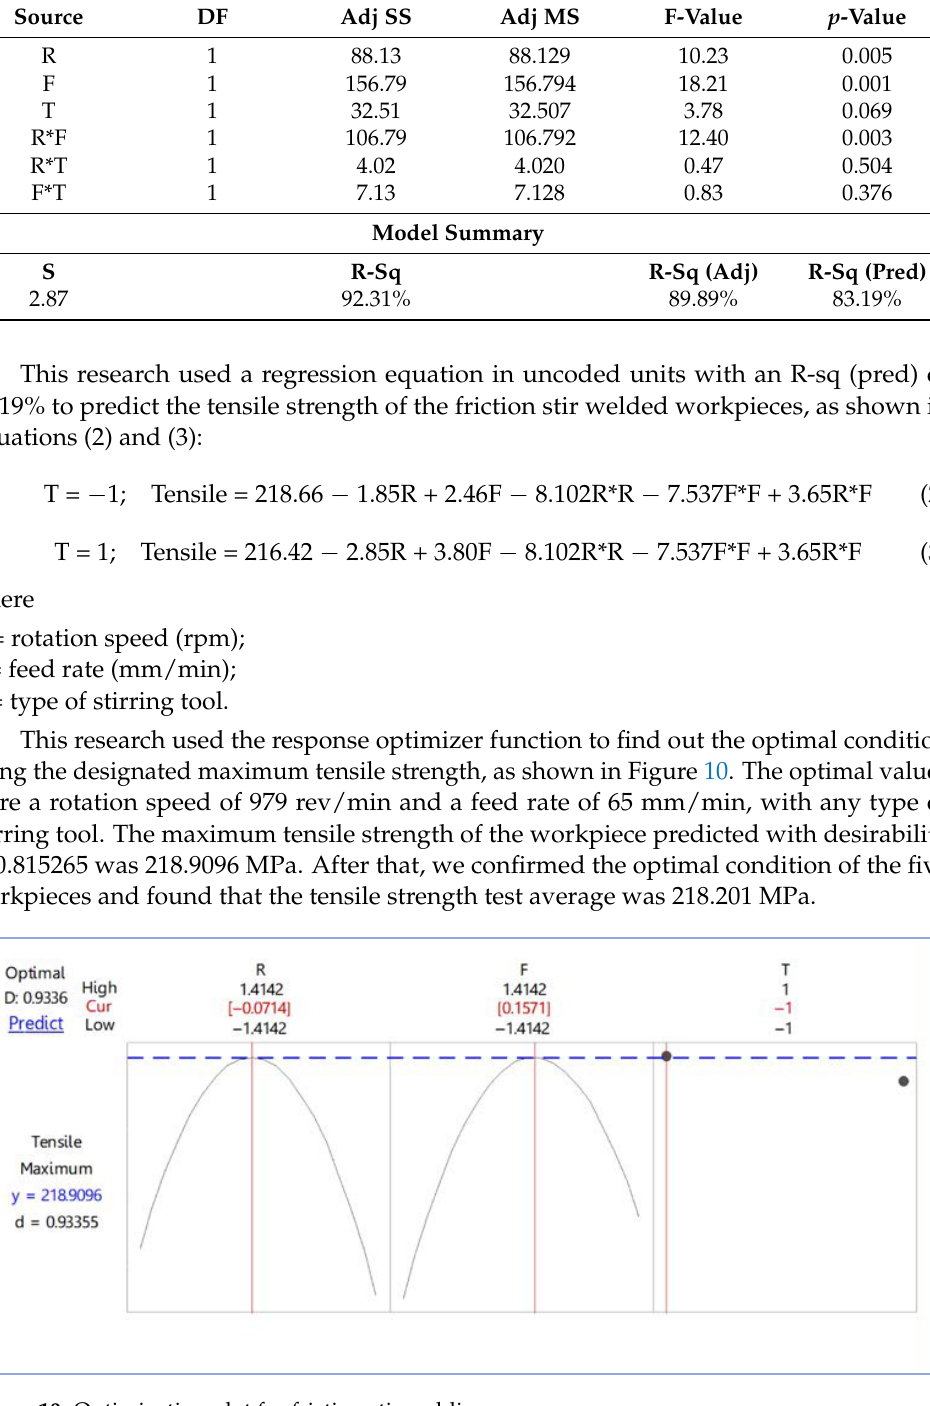
Figure 10. Optimization plot for friction stir welding.